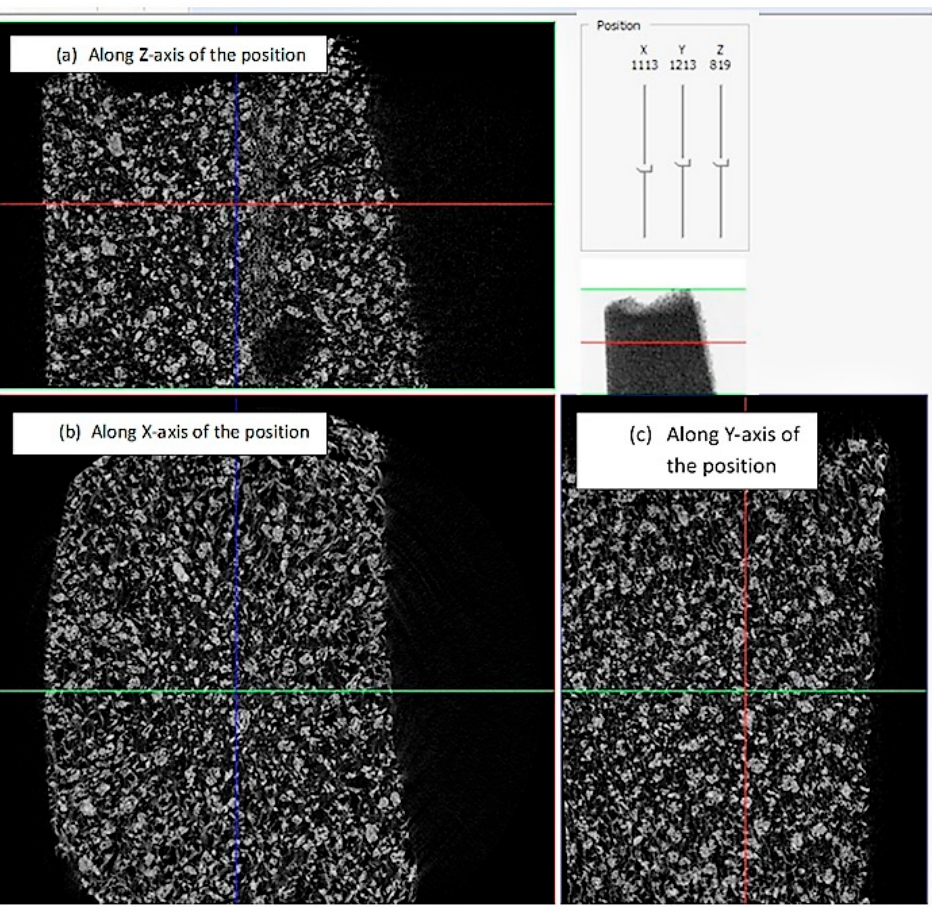
Figure 13. Three-dimensional image of the MRE composite (ZA 22 as matrix) using micro-computed tomography (µCT).